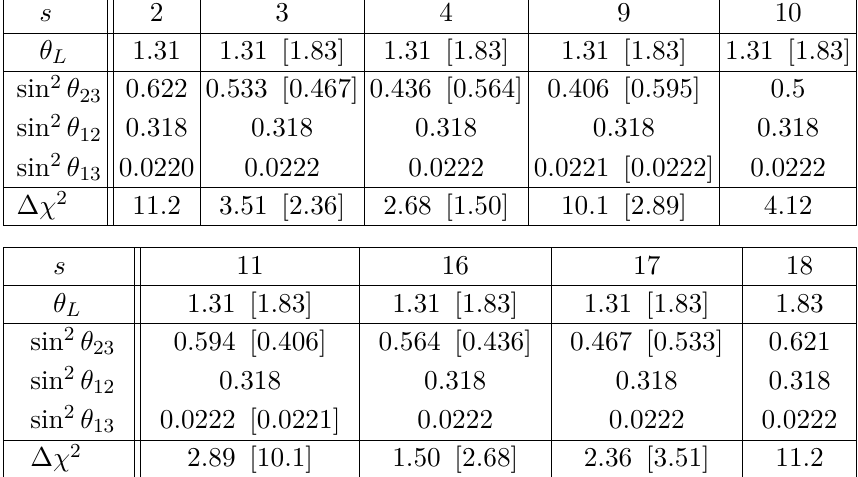
Table 10 . Case 3 b.1) Results for a larger value of n , n = 20 , together with m = 10 and all values of s that lead to a viable description of the experimental data on lepton mixing angles [41]. The goodness of this fit is encoded in the value of ∆ χ 2 , displayed for light neutrino masses with NO. The presence of a second best fit value for θ is indicated in square brackets. L